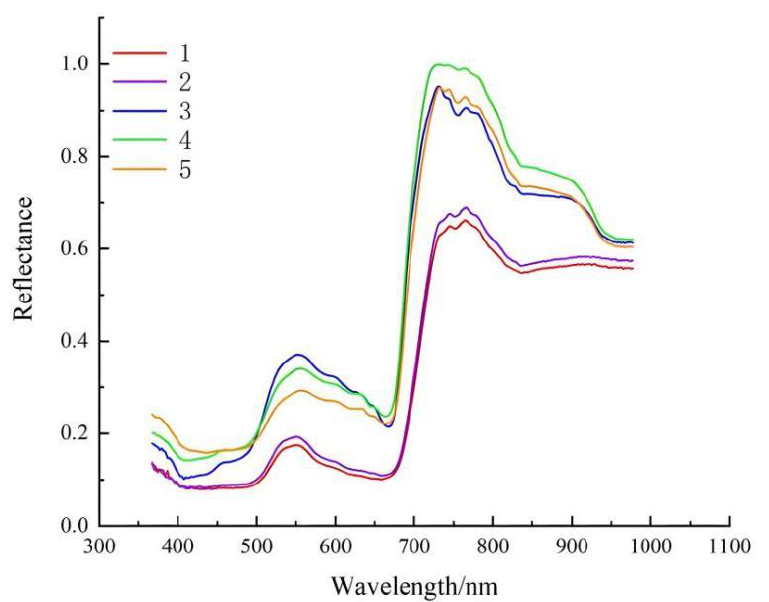
Figure 2. Average reflectance curves of the original spectra of five parts of PsR. Note: 1—old leaf, 2—young leaf, 3—upper stem, 4—middle stem, 5—lower stem.